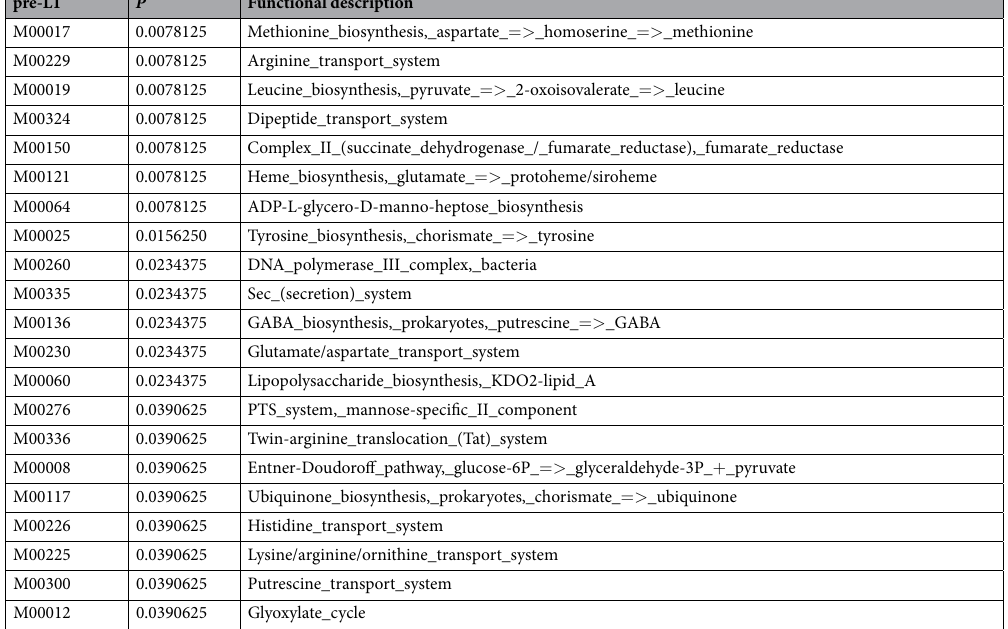
Table 4. Modules enriched in pre-LT samples compared with post-LT